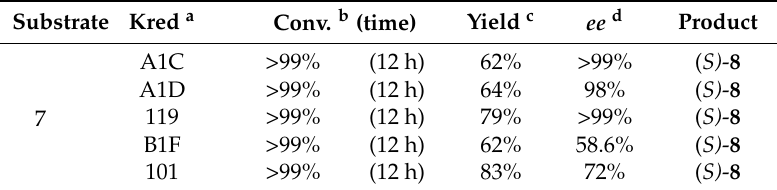
Table 1. Enzymatic reduction of methyl 3-oxohex-5-enoate 7 .